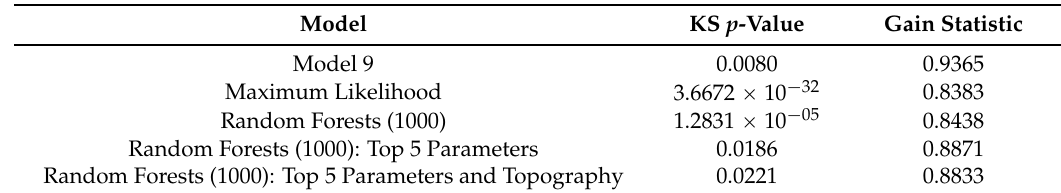
Table 6. Model 9 Results and Other